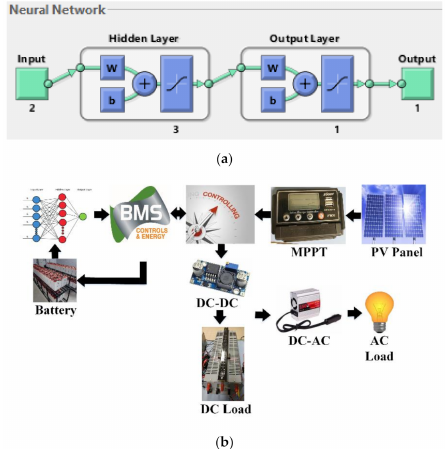
Figure 4. ( a ) Collected battery-data training using MATLAB toolbox; ( b ) Schematic diagram of the proposed model.